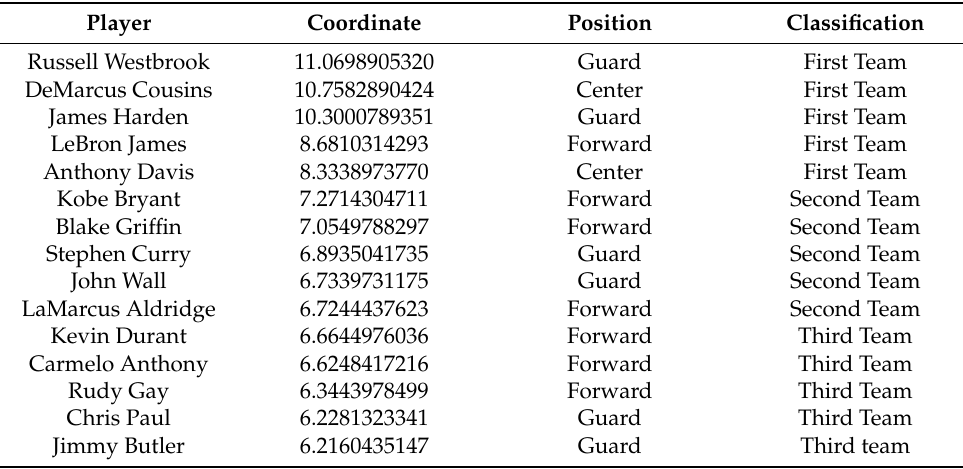
Table A2. All-NBA Teams’ selection through PC1, 2014–15 NBA Season. Player Coordinate Position